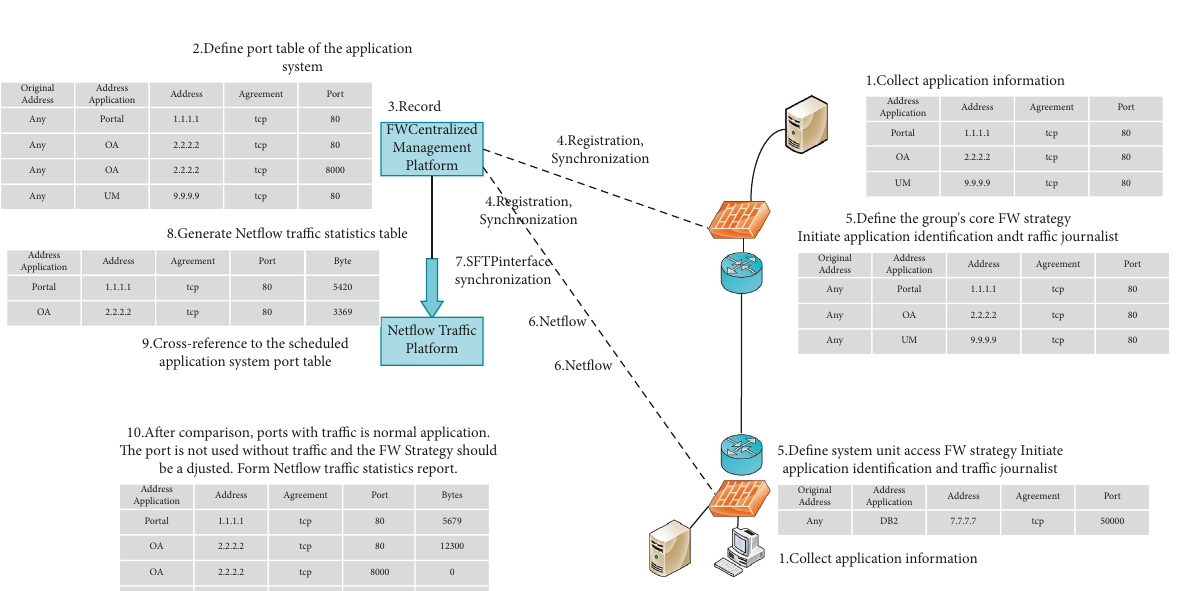
Figure 7: Flow chart of fish bone chart analysis problems.